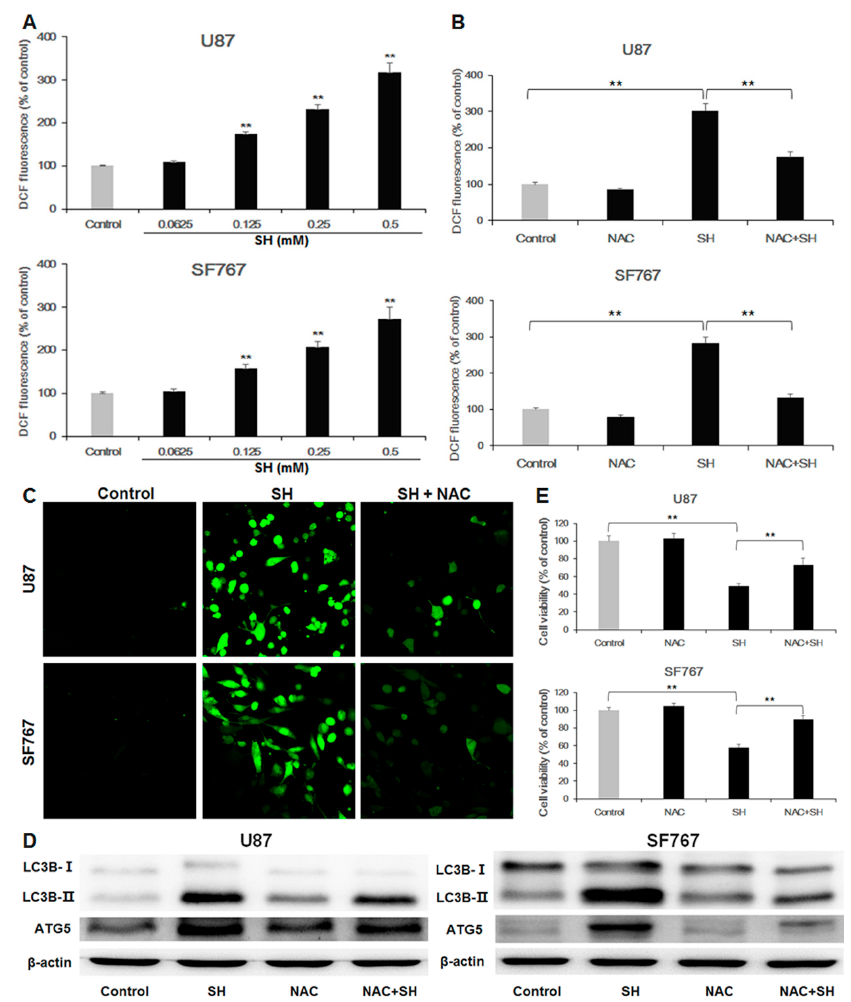
Figure 3. SH induces autophagy-mediated cell growth inhibition via ROS production ( A ) Dose- dependent effects of SH on intracellular ROS levels. U87 and SF767 cells were treated with different concentrations of SH for 24 h, and cellular ROS levels were detected using DCFH-DA probes, with the resulting fluorescence being read by a fluorescence microplate reader; ( B ) Effects of NAC on SH-mediated ROS generation. After pretreatment with the antioxidant NAC, followed by treatment with SH (0.5 mM) for 24 h, ROS levels were tested; ( C ) After pretreatment with the antioxidant NAC, followed by treatment with SH (0.5 mM) for 48 h, the ROS levels were imaged via confocal microscopy; ( D ) Effects of NAC on SH-mediated expression levels of LC3B-II and ATG5 in U87 and SF767 cells. ( E ) Effects of NAC on SH-mediated cell growth inhibition in U87 and SF767 cells. After pretreatment with the antioxidant NAC, followed by treatment with SH (0.5 mM) for 48 h, cell viability was measured via CCK-8 assays. Each image is representative of n = 3 experiments. The results shown in ( D ) are a representative Western blot, n = 3, and β -actin served as the loading control. All data are shown as the mean ± SEM, n = 3. ** p < 0.01, versus the control or SH treatment alone.